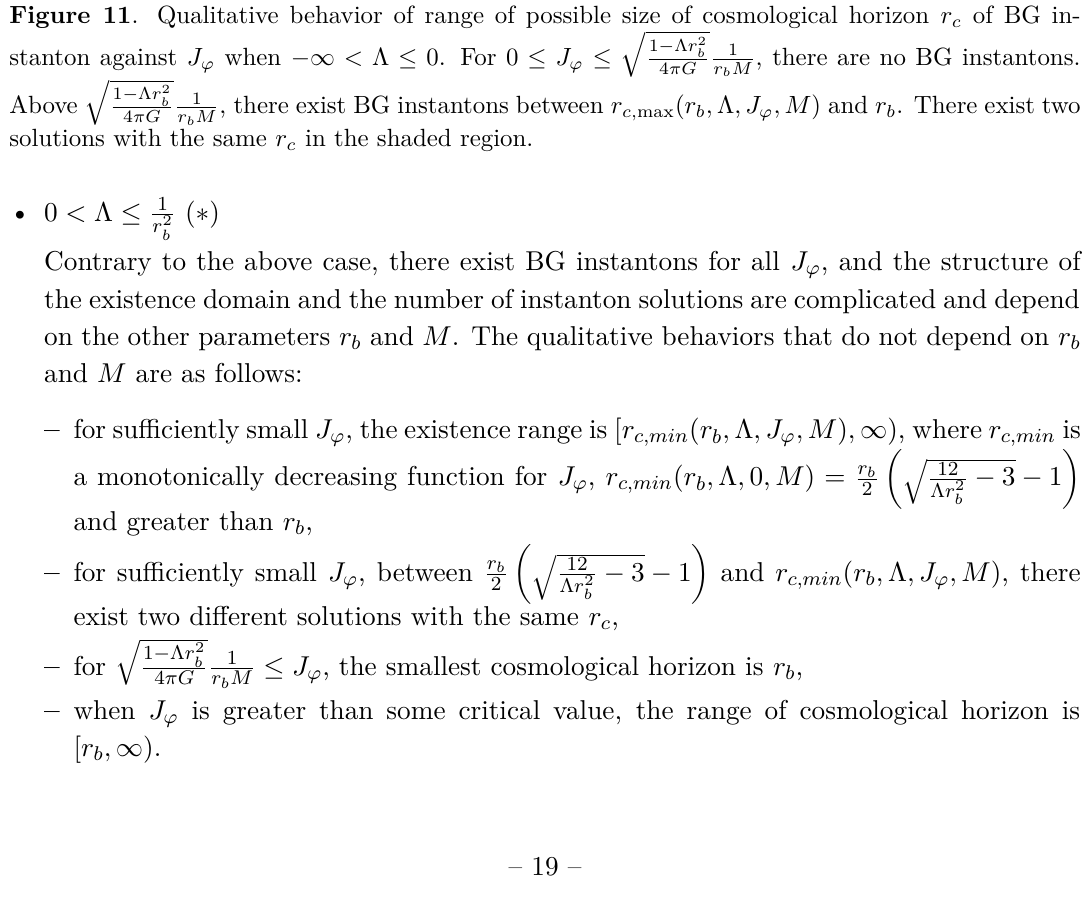
q 1 − Λ r 2 , there are no BG instantons. 1 b ϕ ≤ 4 πG r b M ( r Λ , J ) and r . There exist two c, max b , ϕ , M b